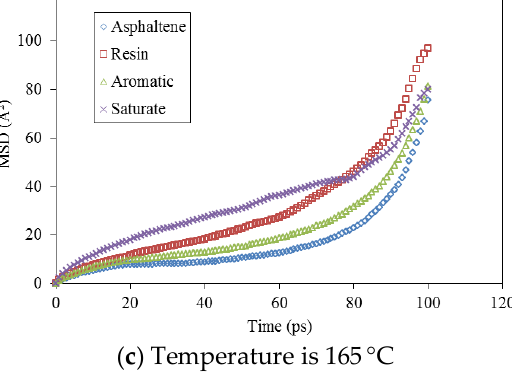
Figure 2. The relationship between mean square displacement (MSD) of four asphalt conponents on the surface of Al 2 O 3 and time: ( a ) Temperature is 25 °C; ( b ) Temperature is 65 °C; ( c ) Temperature is 165 °C.